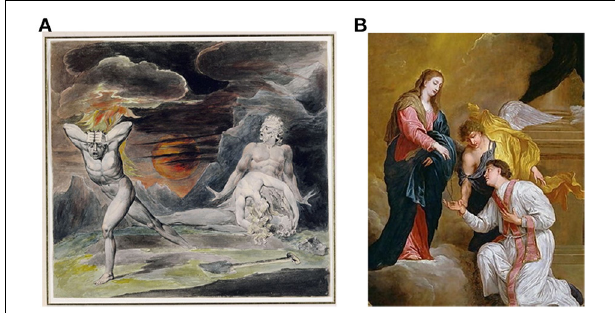
FIGURE 3 | Prominent historical examples of magical thinking, the belief in imaginary agencies, that became commonplace throughout the world, presumably because of its adaptive value for the individual and societies. (A) “Cain Fleeing from the Wrath of God” William Blake, British (1757–1827). The belief that one will be punished by an imagined “God” for immoral acts would be expected to reduce the incidence of such acts. Examples include behaviors that adversely affect monogamous relationships (adultery) or violent acts against other members of a society (murder). (B) “Saint valentine receives a rosary from the virgin” David Teniers III, Flemish, (1600s). The belief in a loving God and “angels” can facilitate cooperation and caring for